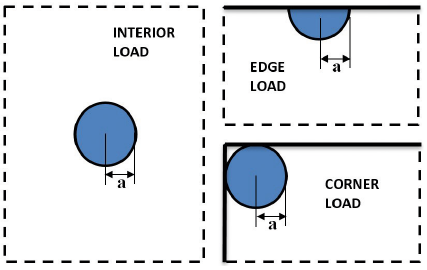
Figure 1. Slab load conditions considered by Westergaard (Westergaard,